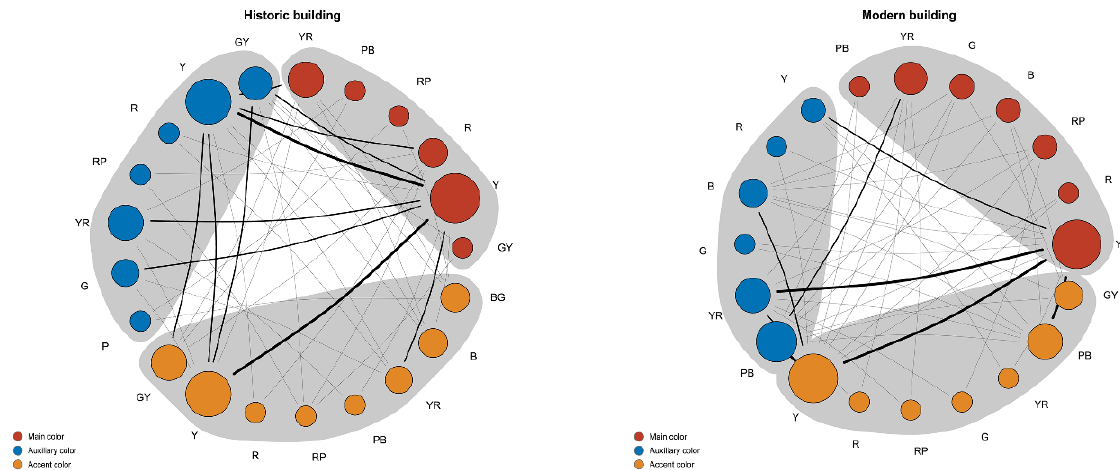
Figure 8. Chromatic composition network of historic and modern buildings.